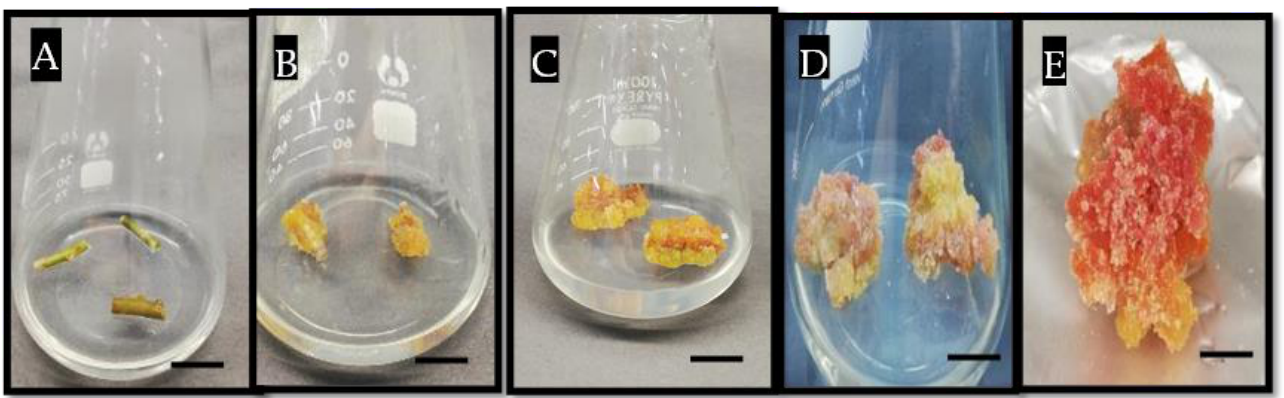
Figure 1. In vitro callus induction of Bougainvillea glabra Choisy under light incubation condition. ( A ) Sterilized nodal segment on WPM basal medium; ( B ) callus induction from a node section on WPM medium supplemented with 5 µM 2,4-D + 1 µM BAP after 4 weeks; ( C ) callus after 6 weeks in the same medium and PGRs condition; ( D ) callus after 8 weeks; ( E ) callus induction from a node section on WPM medium fortified with 7.5 µM 2,4-D + 1.5 µM BAP after 10 weeks with a red spot.